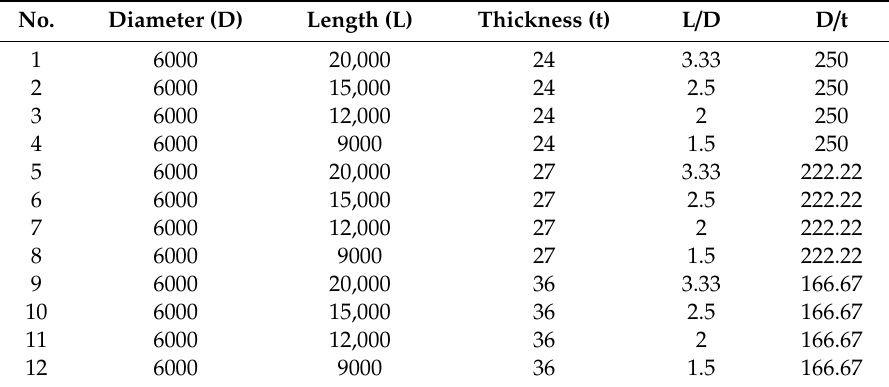
Table 1. Model geometry size in the FEM